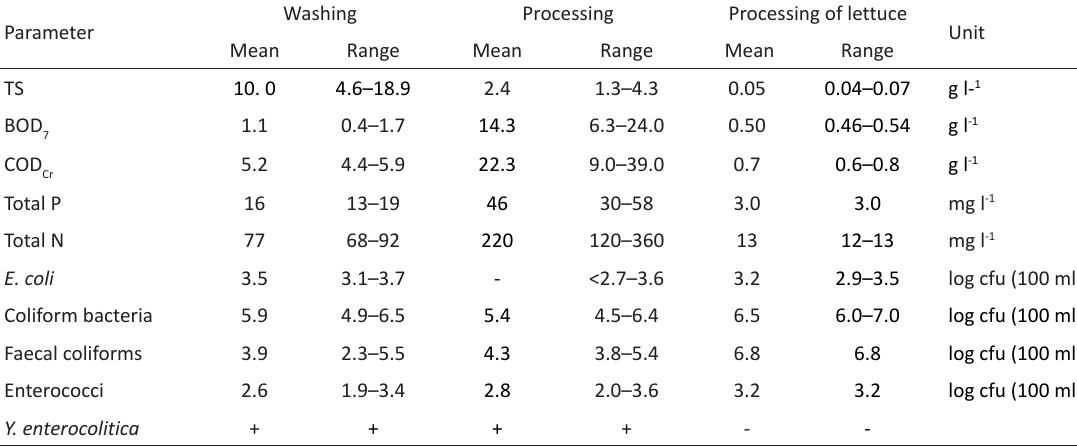
Table 2. Means and ranges of the quality parameters of wastewaters in the washing (A1, B1, C1), and processing phase (B2, C2, D2), N=6, and processing of lettuce (D3), N=2. Samples were taken after the washing period, after the peeling machine and after the washing of lettuce. Samples were mixed samples of one